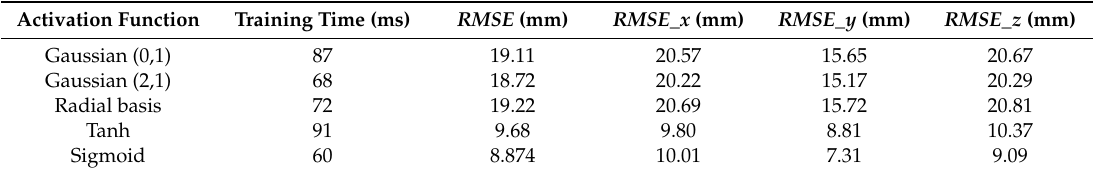
Table 2. Comparison experiments using di ff erent activation functions on training data set.